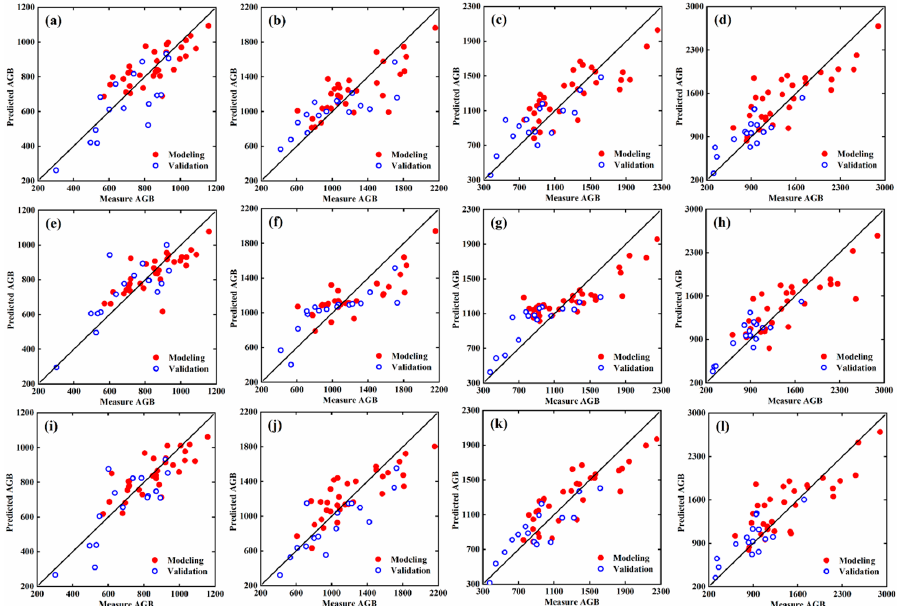
Figure 15. Scatter plots between measured and predicted values of potato AGB (kg/hm 2 ) for mod- eling and verification data sets using GPR-based composite variables by MWPLS, MC-UVE, and RF at different growth periods. ( a – d ) Relationship between measured and predicted values of potato AGB based on MWPLS-GPR for bud period, tuber-formation period, tuber-growth period, and starch-storage period, respectively. ( e – h ) Same as panels ( a – d ) but based on MC-UVE-PLSR. ( i – l ) show the same as panels ( a – d ) but based on RF-GPR.